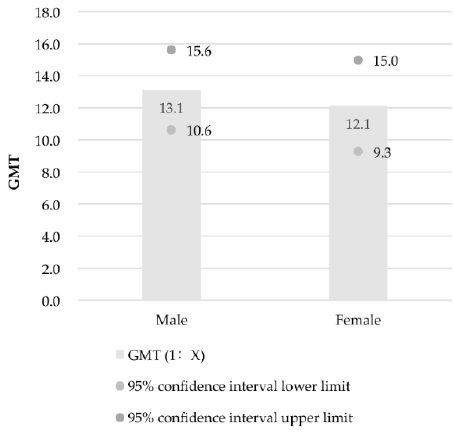
Figure 4. GMT and GMT 95% confidence intervals of EV71 neutralizing antibodies in different genders of children.